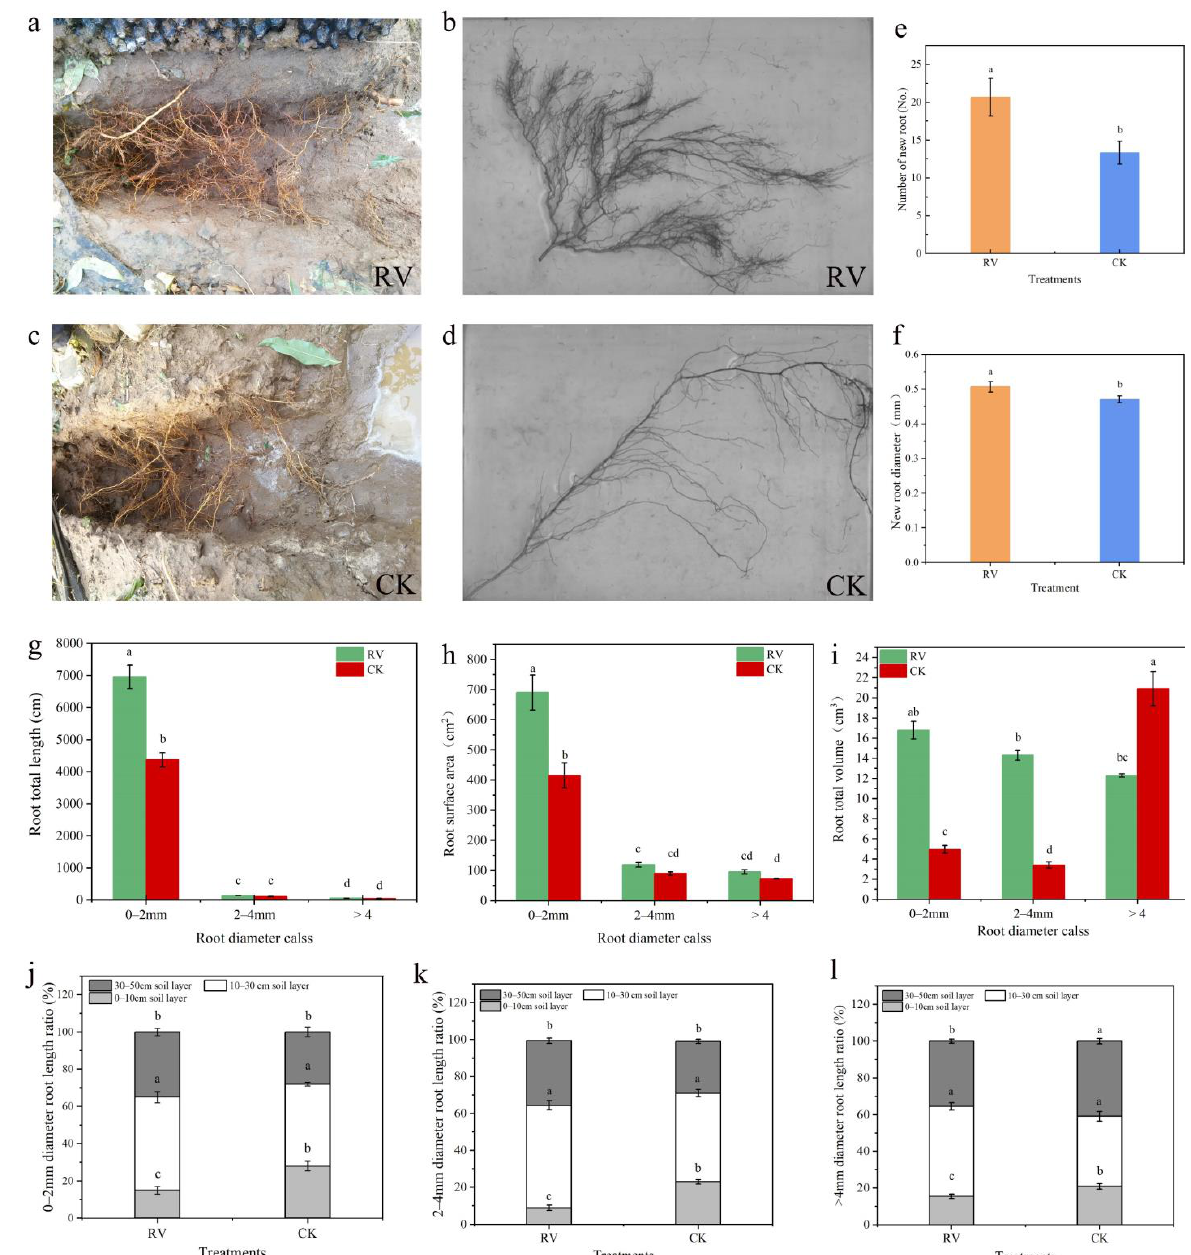
Figure 6. Effects of root-zone aeration on the root growth and root system architecture of peach trees: ( a ) Root system under root-zone aeration treatment. ( b ) Root system scan image under root-zone aeration treatment. ( c ) Root system under control conditions. ( d ) Root system scan image under control conditions. ( e ) Number of new roots. ( f ) Diameter of new roots. ( g ) Root s’ total length. ( h ) Root s’ total surface area. ( i ) Root s’ total volume. ( j ) Distribution characteristics of root systems with diameters of 0 – 2.0 mm in the vertical direction. ( k ) Distribution characteristics of root systems with diameters of 2.0 – 4.0 mm in the vertical direction. ( l ) Distribution characteristics of root systems with diameters of >4 mm in the vertical direction. Each point represents the mean ± standard error ( n = 3). Different lowercase letters indicate significant differences between treat- ments ( p < 5%, two-way ANOVA).